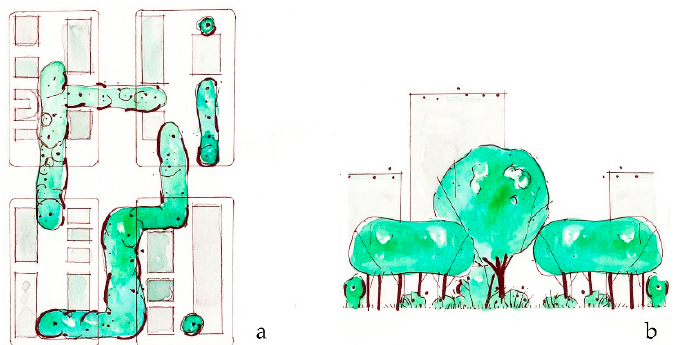
Figure 8. Connect experiences describes how having a continuous, pleasant walking environment can increase physical activity by providing greenery along streets or paths. ( a ) Plan view of connected green spaces; ( b ) Sketch elevation of connected